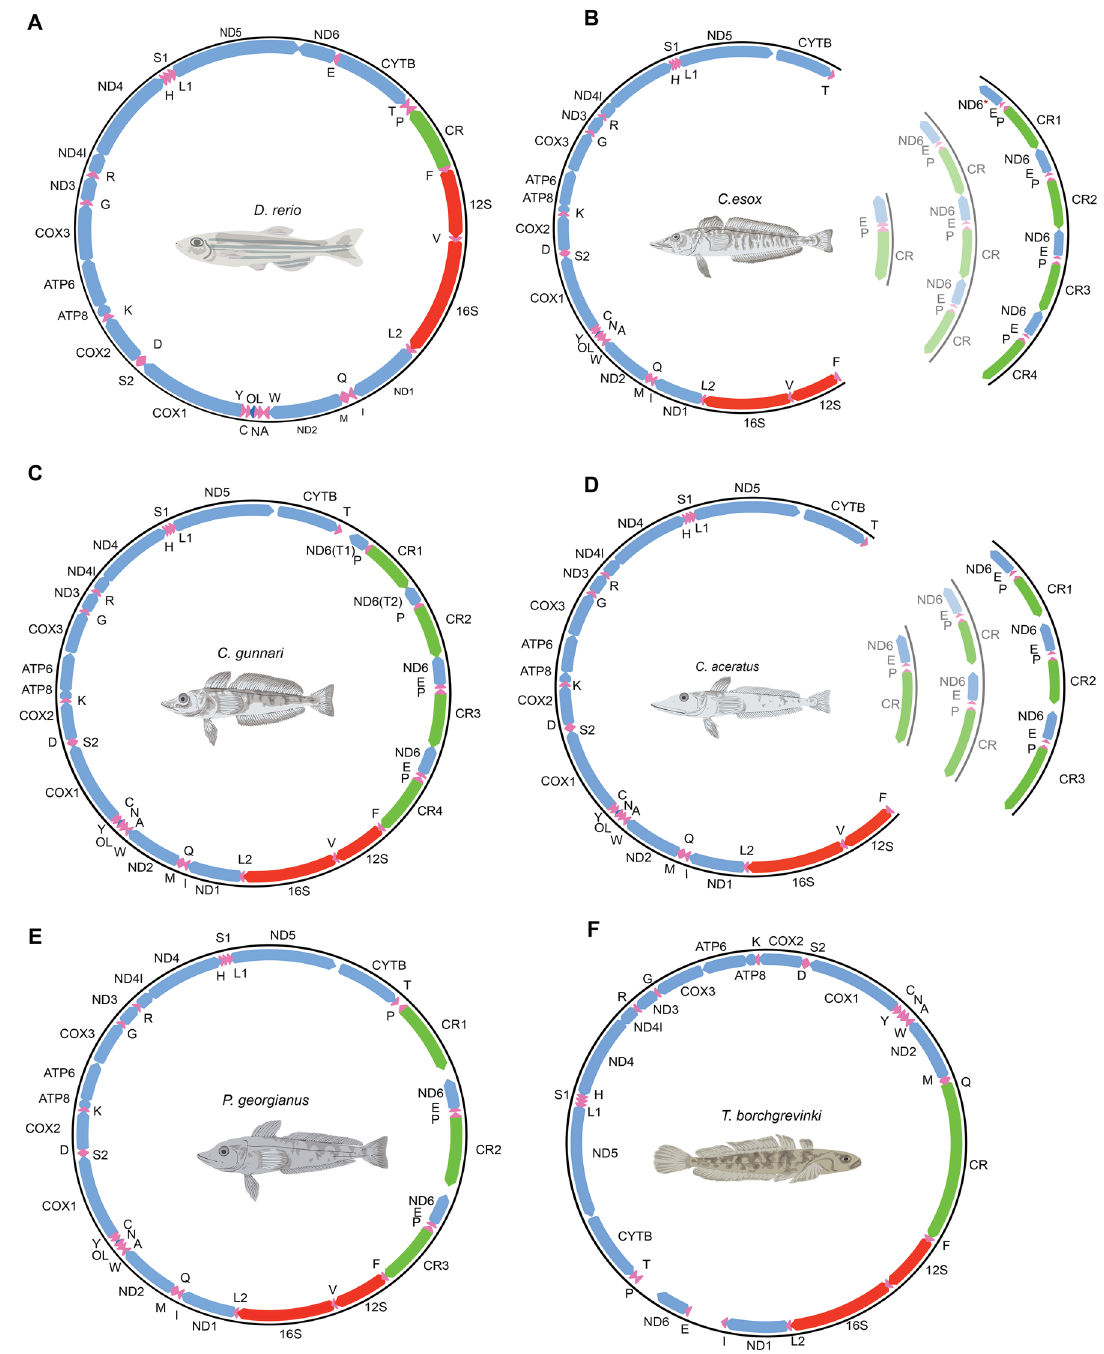
Figure 1. Complete annotated mitogenomes of species in this study. Protein coding genes are colored as blue, tRNAs as pink, ribosomal subunits genes as red, and control region is colored in green. The lighter colors in C. esox and C. gunnari depicts the different variants of mt genome with the darker portions showing the primary assembly for that species. ( A ) Mitogenome of Danio rerio showing gene order of a typical mt genome ( B ) Mitogenome of C. esox showing heteroplasmy where we have observed reads showing variable mitogenomes with different numbers of the tandemly duplicated region ND6 / trnE / trnP /CR, with reads having one, three and four copies of the duplicated block. ( C ) Mitogenome of C. gunnari with two complete blocks of ND6 / trnE / trnP / CR region and two blocks with ND6-T / trnP /CR where ND6-T depicts the truncated copy of the ND6 gene. ( D ) Mitogenome of C. aceratus showing heteroplasmy with one, two, and three copies of the ND6 / trnE / trnP /CR region. ( E ) Mitogenome of P. georgianus with two copies of the duplicated ND6 / trnE / trnP /CR region, and an additional copy of just trnP /CR. ( F ) Mitogenome of T. borchgrevinki showing an expanded control region within an inversion of 6551